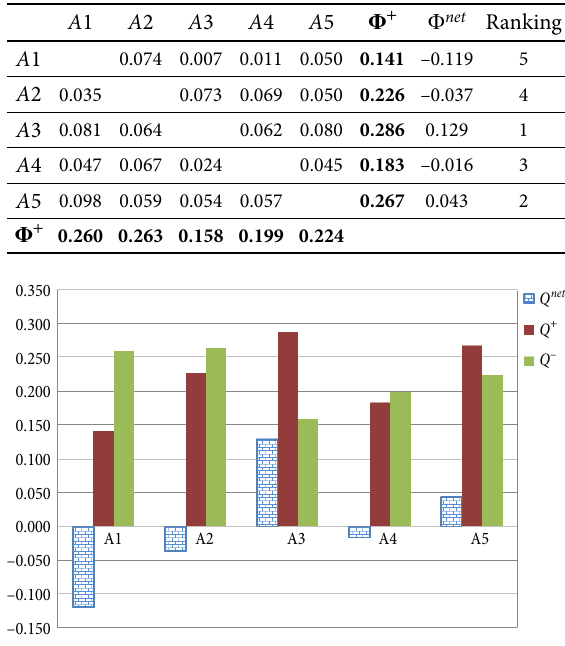
Table 8. The preference index